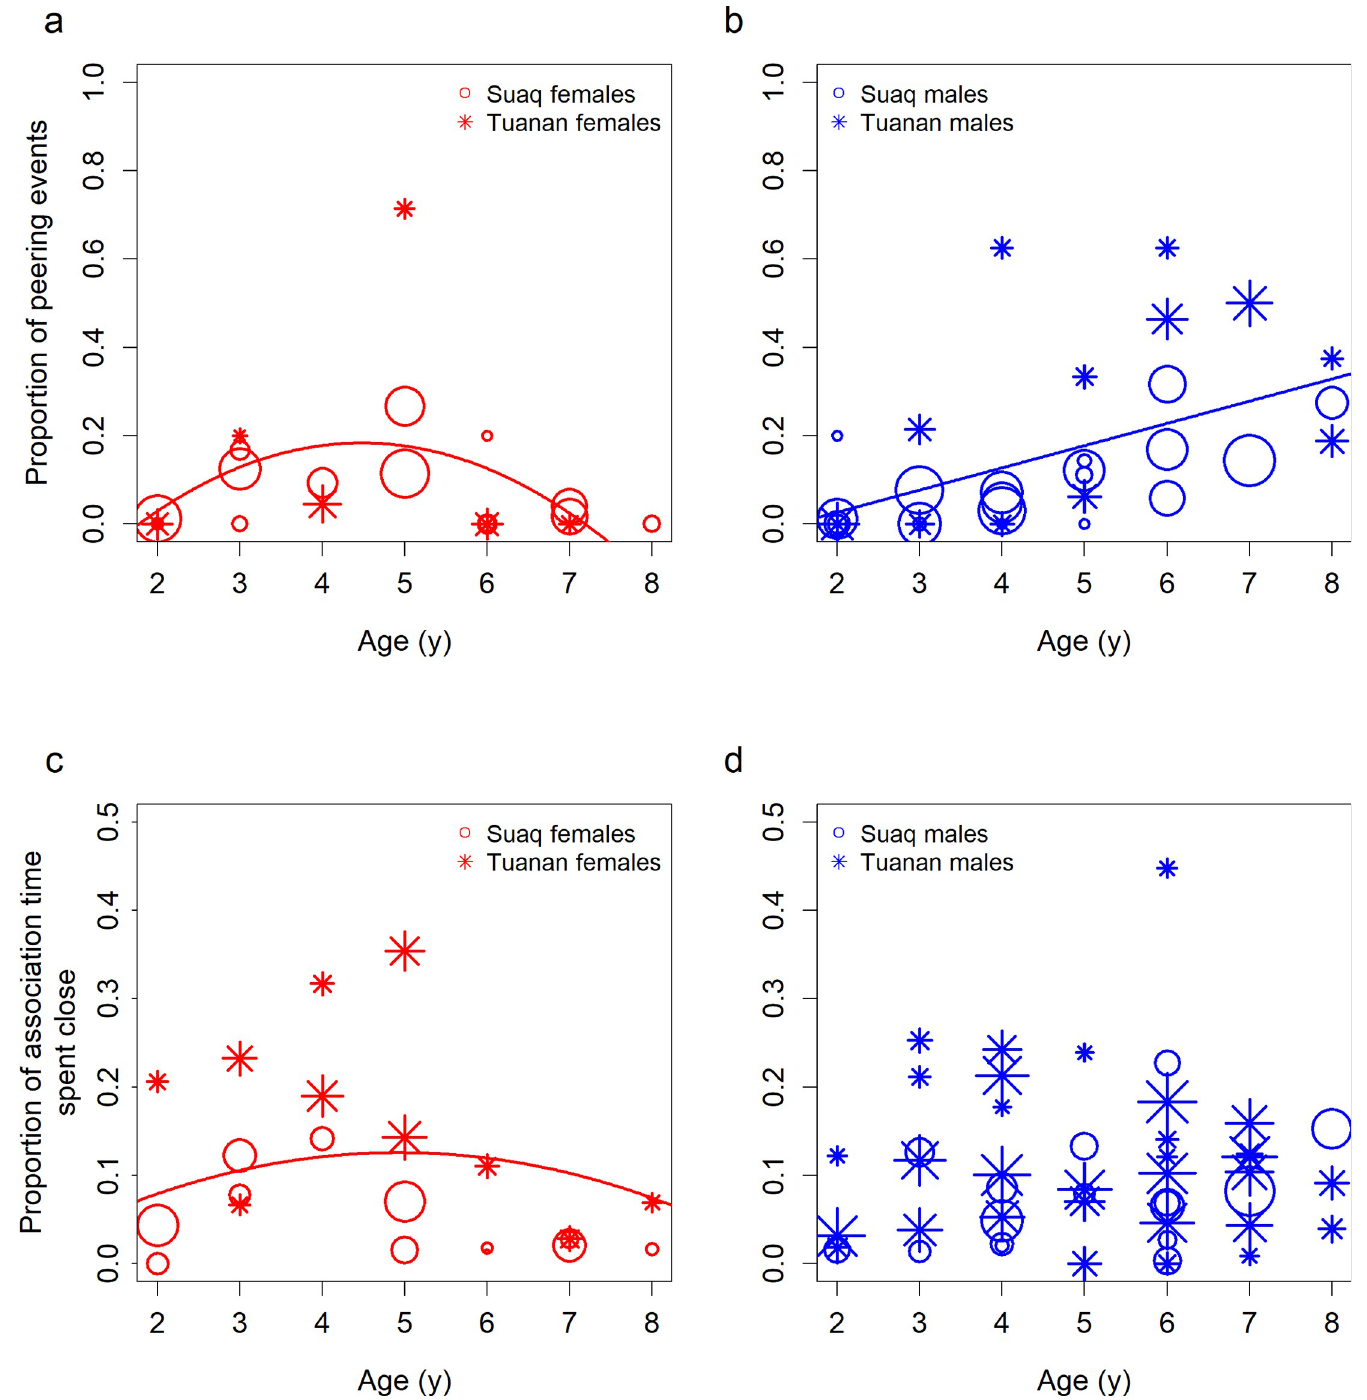
Fig 1. Development of social interest in immatures. Proportion of peering events in the feeding context that immature females (a) and males (b) directed at individuals other than their mother, over age, with N = 56 peering proportions based on 2,355 peering events by the immatures (802 events by immature females and 1,548 events by immature males). The proportion of association time that immature females (c) and males (d) spent in close proximity to individuals other than the mother, over age, with N = 71 association proportions based on 3,983 association hours (1,051 hours of immature females and 2,932 hours of immature males) of the immatures with non-mother association partners. The lines depict the best model fit for each sample. Symbol sizes correspond to sample sizes (i.e., number of peering events) for (a) and (b) and number of association hours for (c) and (d). The underlying data for this figure can be found in S1 Data.